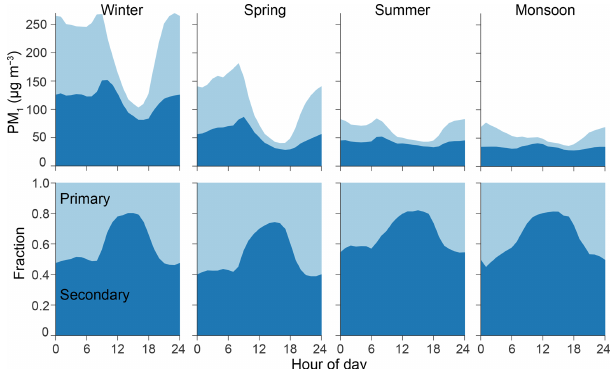
Figure 11. Average diurnal variation of mass concentrations and mass fractions of primary and secondary C-PM 1 by